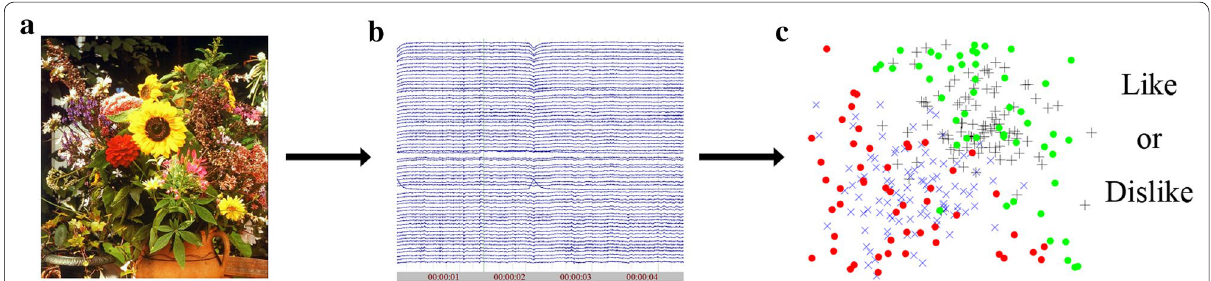
Fig. 5 A workflow for aesthetic preference prediction based on neuroimaging data. a The original picture. b Neuroimaging data are recorded by EEG, MEG, or fMRI when participants are viewing images. c Bio-features are extracted from neuroimaging data and machine learning algorithms are applied to give a prediction of aesthetic